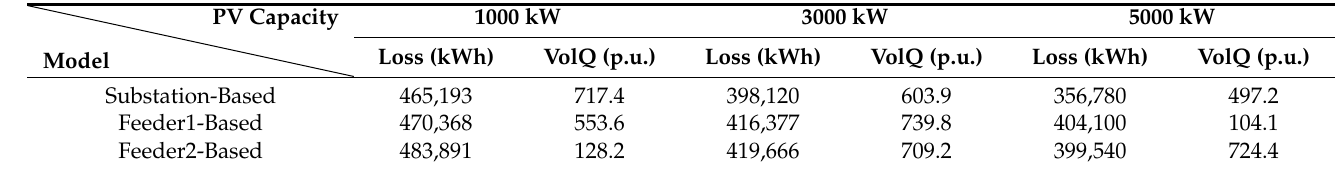
Table 6. The comparison of optimal multi-objective values between the different